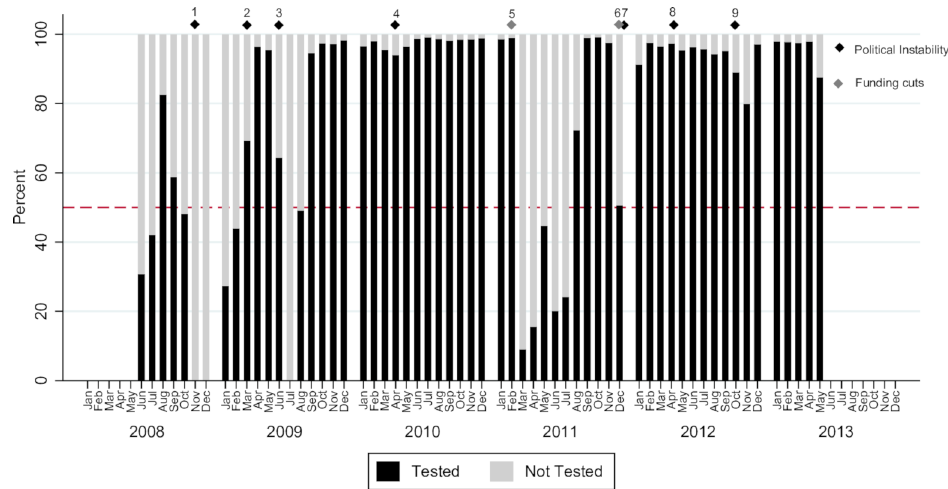
Fig 1. Percent coverage of peripartum opt-out HIV-testing at the Simão Mendes National Hospital, June 2008 to May 2013 (n = 31,443). Legend. The figure displays the percentage of women tested by calendar month and year. The black diamonds indicate periods of political instability, while the grey diamonds indicate major funding cuts. Timeline: 1. Failed coup, gun attack on President Vieira’s home. 2. President Vieira assassinated hours after a bomb attack that killed the army’s chief of staff. 3. Military police kill one of the presidential candidates in bid to foil a "coup". 4. Mutinous soldiers detain Prime Minister Carlos Gomes Jr. and replace armed forces chief. 5. EU suspends parts of its aid due to concern over governance. 6. Global Fund (GF) and implementing partners withhold funding to HIV programme. 7. Foiled coup attempt against President Malam Bacai Sanha. 8. Coup-Soldiers topple government, and leading presidential contender Carlos Gomes Jr. arrested. 9. Failed coup attempt.